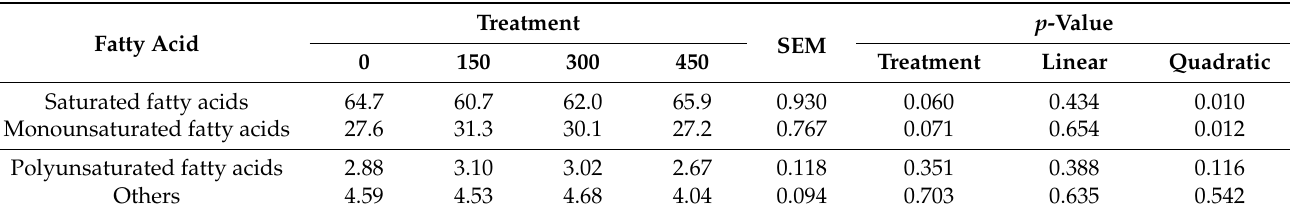
Table 4. Total fatty acid (g/100 g of total fatty acids) groups in milk from crossbred F1 dairy cows fed on tropical grasses and supplemented with different levels of concentrate (0, 150, 300 and 450 g of DM concentrate/kg of daily milk